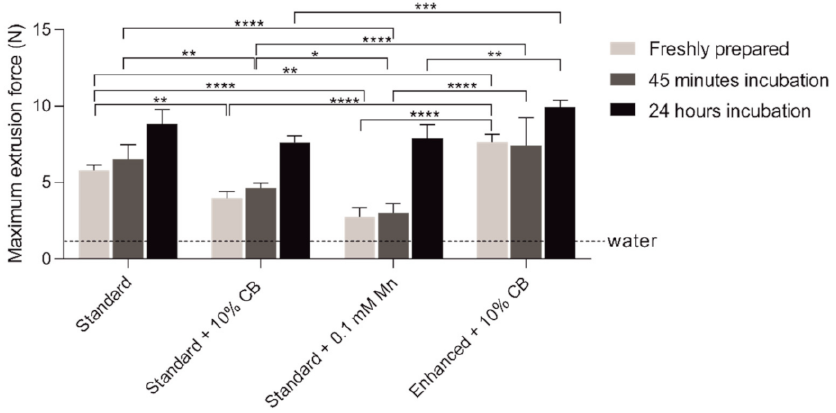
Figure 3. Injectability analysis of alginate-based hydrogels: Extrusion force needed to inject the different hydrogels’ formulations into aCSF, using tuberculin (1 mL) syringe with 27G needle. The hydrogels were measured freshly prepared and after 45 min incubation with aCSF. Data presented as mean ( ± SD), n = 3. * p < 0.05; ** p < 0.01; *** p < 0.001; **** p < 0.0001 compared to